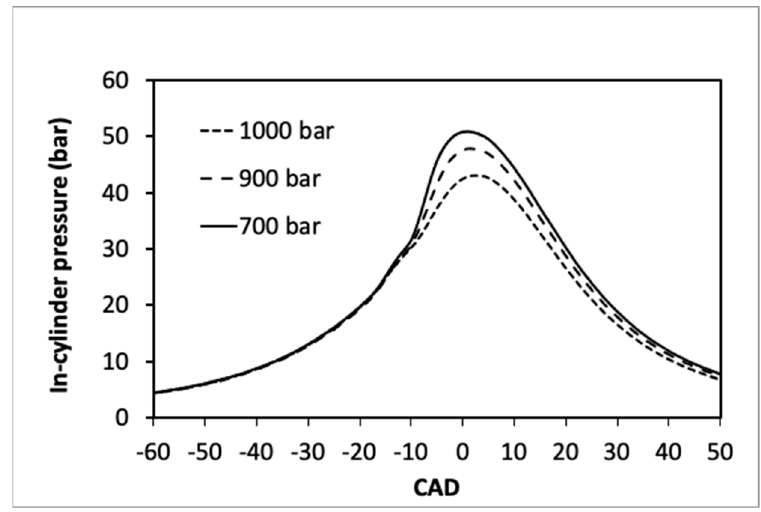
Figure 5. Experimental in-cylinder traces versus CAD at 1000 rpm and varying injection pressure.